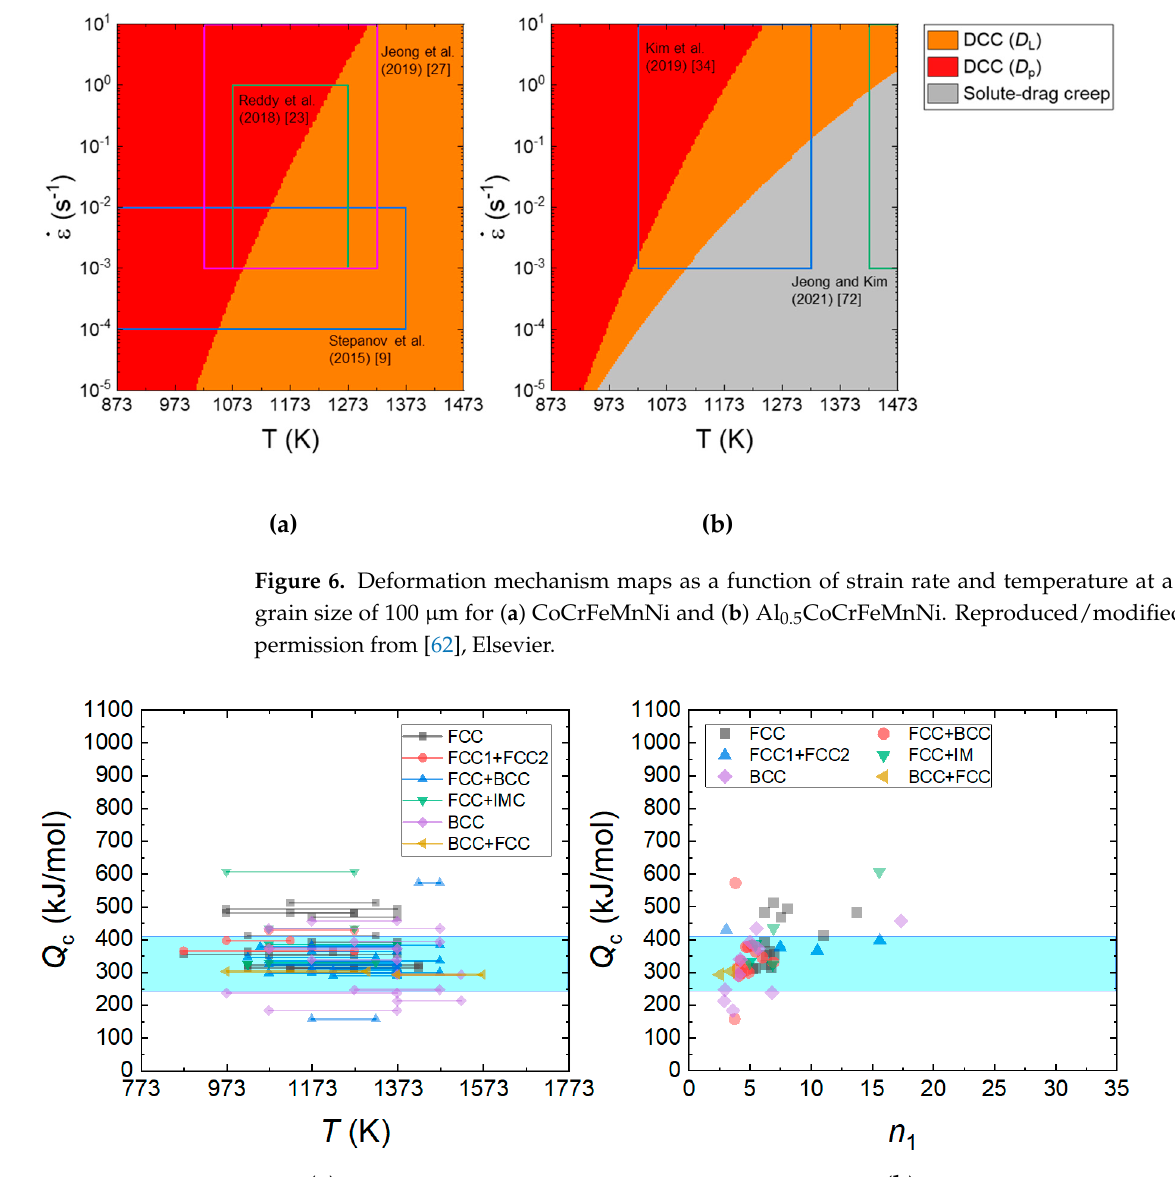
Figure 6. Deformation mechanism maps as a function of strain rate and temperature at a given grain size of 100 μ m for ( a ) CoCrFeMnNi and ( b ) Al 0.5 CoCrFeMnNi. Reproduced/modified with permis- sion from [62], Elsevier.